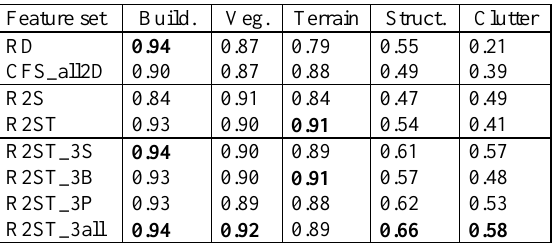
Table 6. Completeness of selected feature sets for buildings (Build.), vegetation (Veg.), terrain, structures (Struct.) and